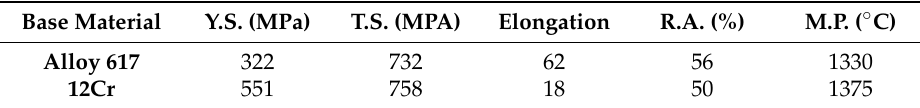
Table 2. Mechanical properties of Alloy 617 and 12Cr